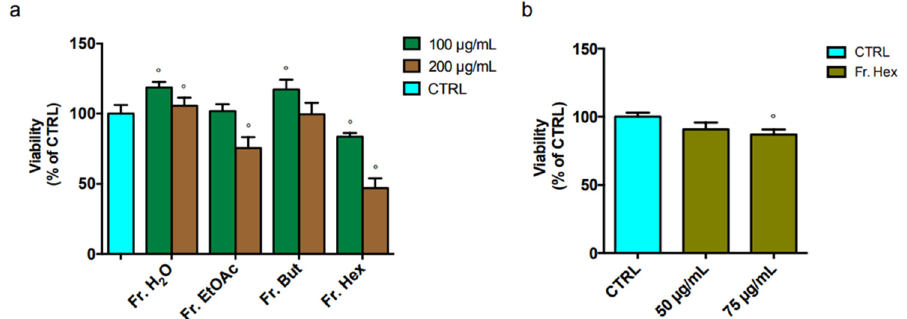
Figure 8. Cell viability of BV-2 treated with different concentrations of chestnut leaf extract fractions. BV-2 cells were treated for 3 h with ( a ) 100 or 200 µ g/mL of different leaf-derived extract fractions or ( b ) 50 or 75 µ g/mL of leaf-derived Fr. Hex (olive bars). Viability was evaluated by MTT assay, as described in the Materials and Methods section. Each bar represents the mean of n = 10 samples ± SEM. Statistical analysis was performed by Fisher’s LSD test following one-way ANOVA. ° p < 0.05 significantly different from control cells.